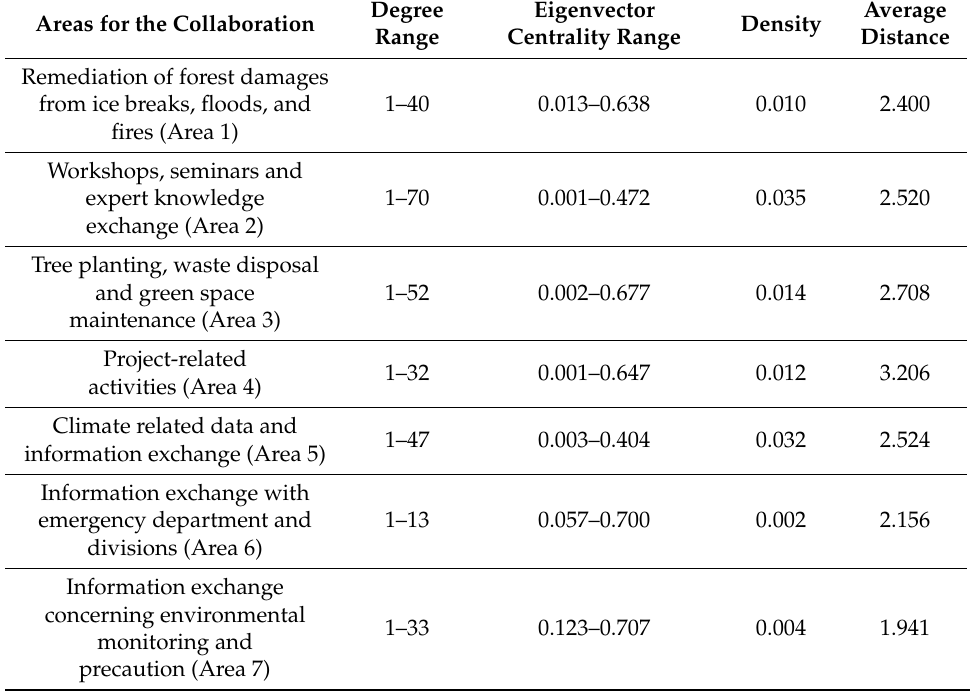
Figure 3. Collaboration network in climate change governance in forestry and nature conservation. A graph is in multidi- mensional scaling layout (MDS) as defined by UCINET. More connected organizations are displayed close to each other; orientation (left–right; top–bottom) is arbitrary. The shape and color of the organizational symbol reflect governance level (national level—circle, blue color; regional level—square, purple color; local level—triangle, orange color). The size of the organizational symbol and label is in proportion to the results of their tie range. Tie thickness and color are scaled according to the frequency of contacts. The highest tie thickness in black color represents daily and weekly contact frequency, highest thickness in grey color represents monthly contact, whereas thin grey ties represent quartal and yearly frequency of contact. Table 5. Structural characteristics of networks per areas for the